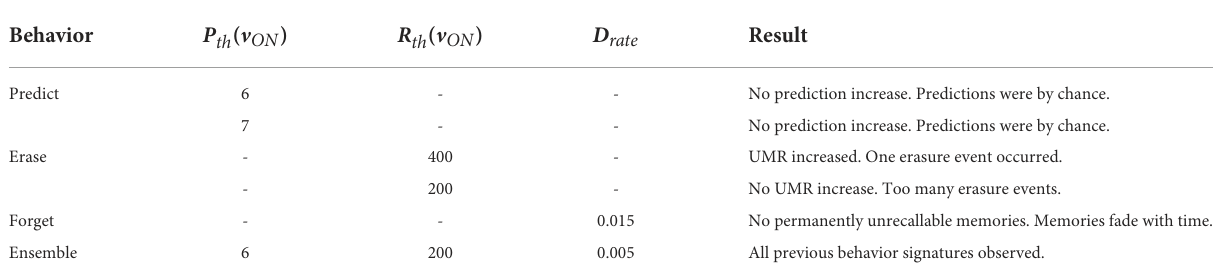
TABLE 2 Summary of expanded behavior